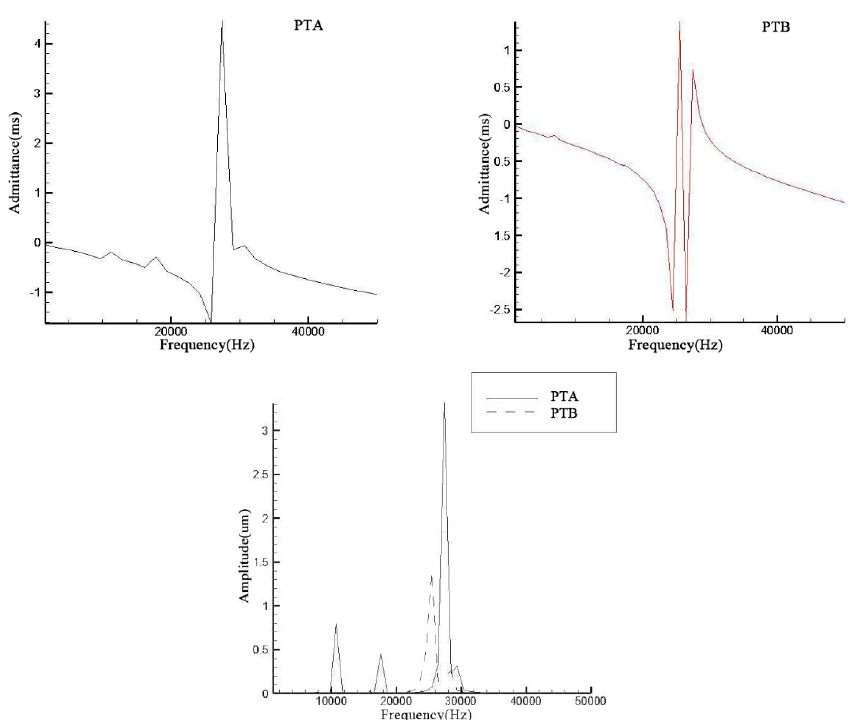
Figure 9. Simulation results of two transducers.